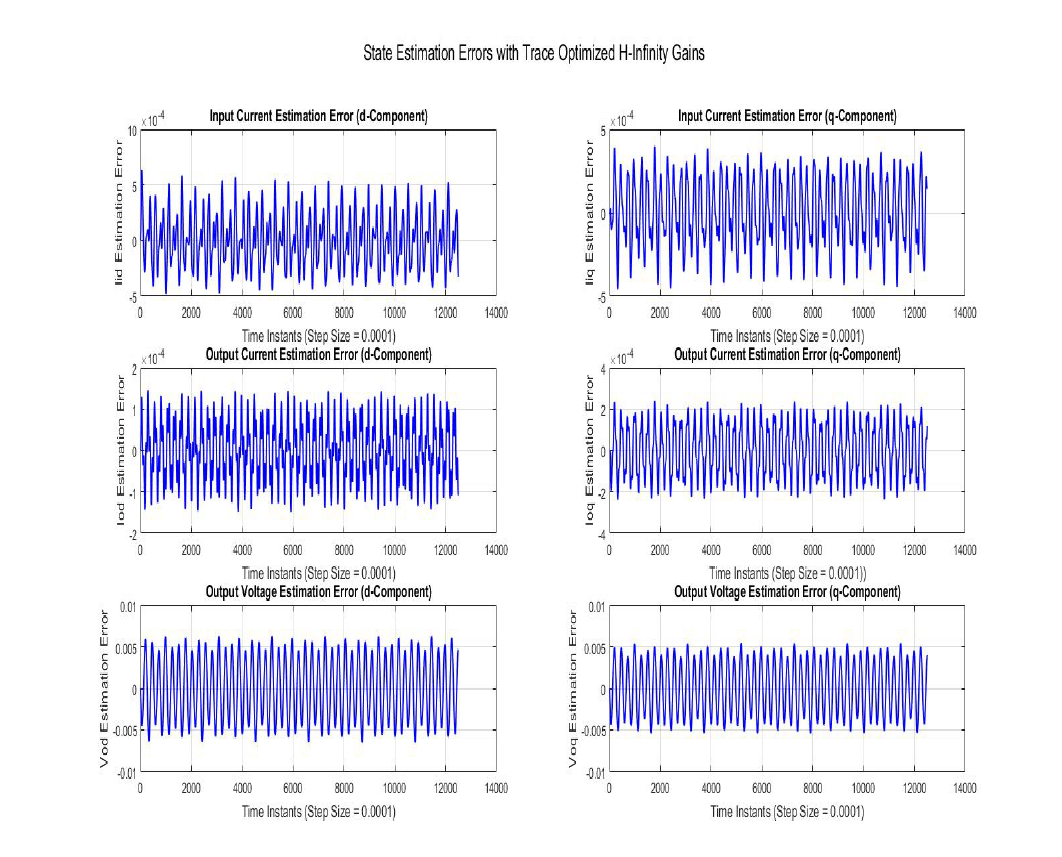
Figure 8. State estimation errors with trace optimized H ∞ SMO